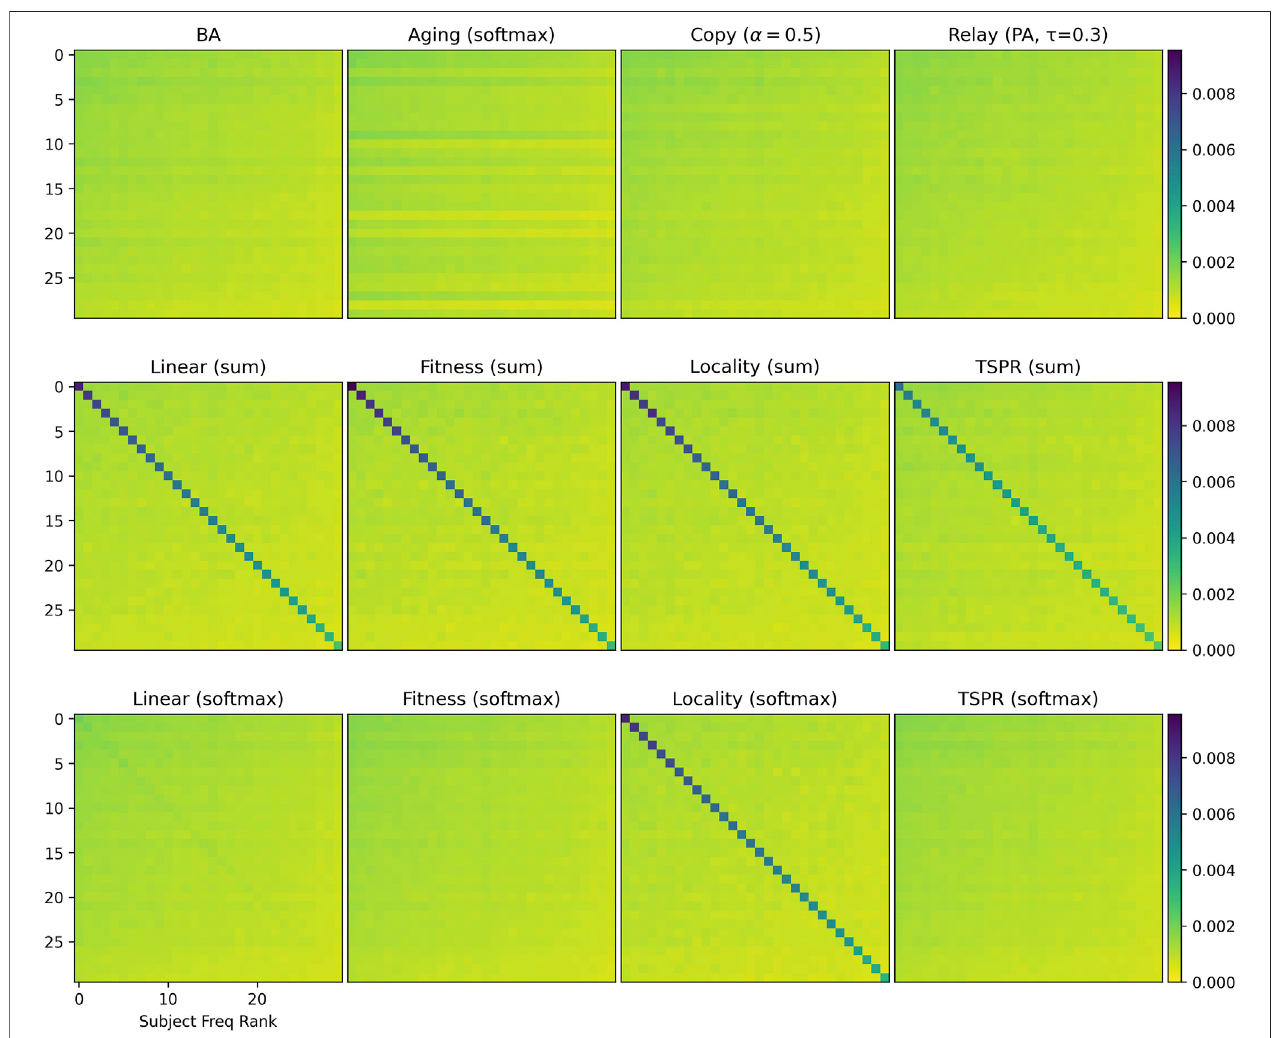
FIGURE 2 | H norm subject signatures for simulated baselines (top row) , sum-normalized subject models (middle row) , and softmax-normalized subject models (bottom row) . Subjects are indexed by descending frequency from 0 to 30.